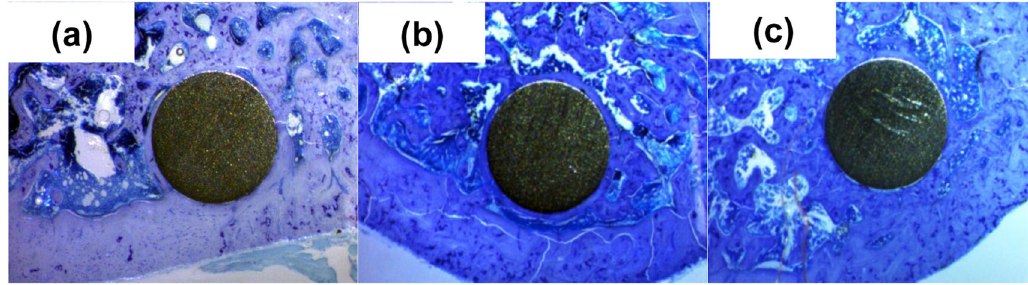
Fig. 4 Histology of femurs after 60 days of implantation for: a Ti6Al4V as received, b Ti6Al4V 800 , and c Ti6Al4V 1050